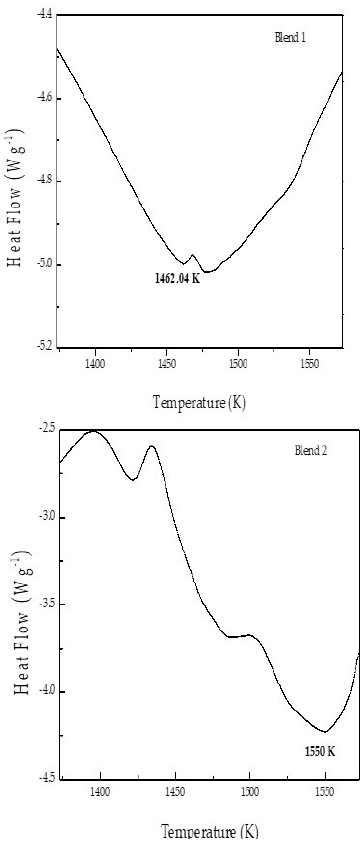
Figure 4. Estimation of melt formation temperature of sinter Blends 1 and Figure 4 . Estimation of melt formation temperature of sinter Blends 1 and 2 .